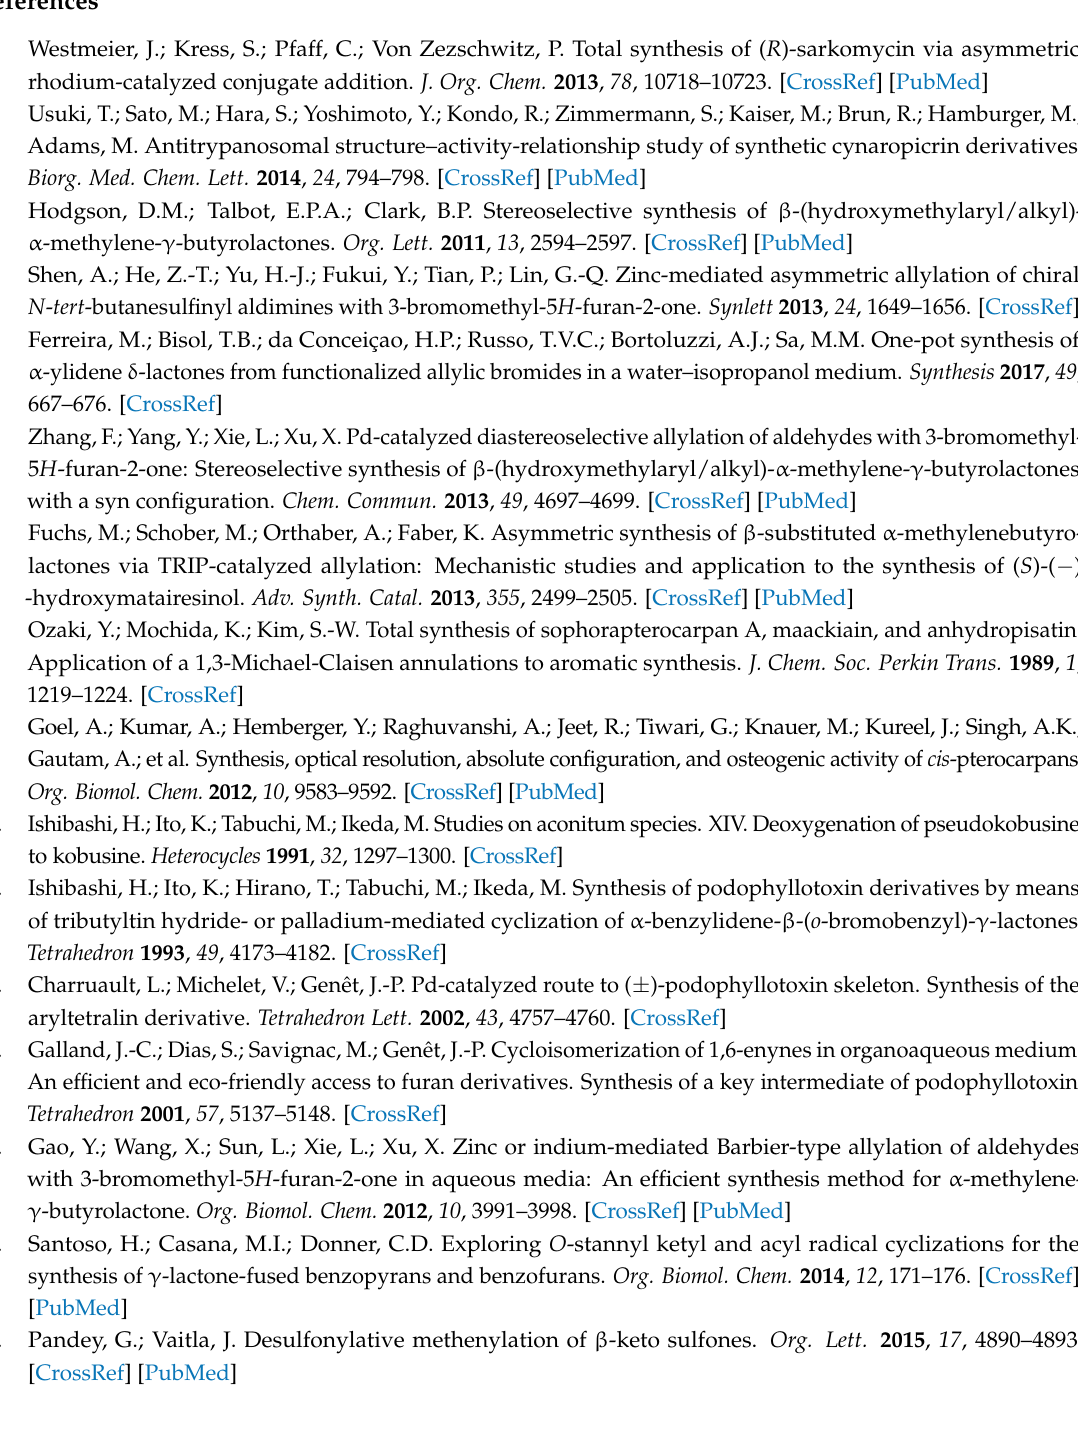
Supplementary Materials: Representative synthetic procedures, characterization data of new compounds, as well as NMR and X-ray data are available online, experimental procedures as well as analytical data for new